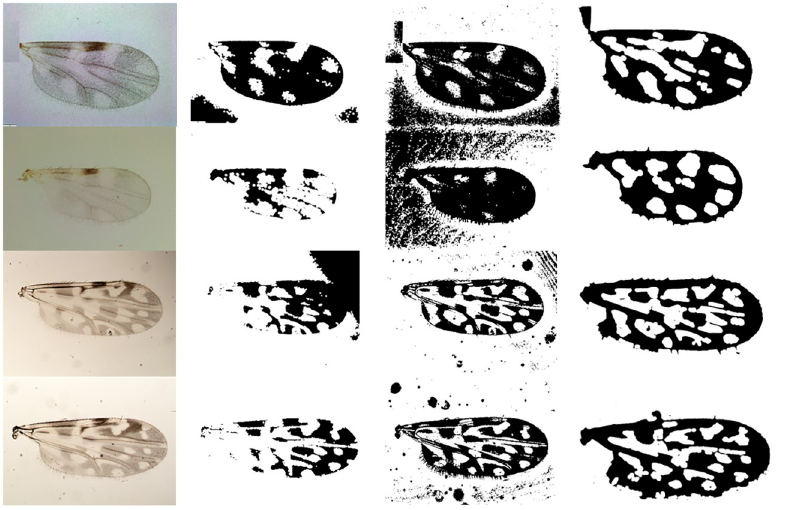
Fig 11. Wing and particles segmentation performance using the Otsu’s method on C.obsoletus (first row), C. pusillus (second row), C.foxi (third row), and C.insignis (fourth row) samples. From left to right, original wing image, Guerro´n et al. [23], Benalca´zar et al. [24], and proposed method